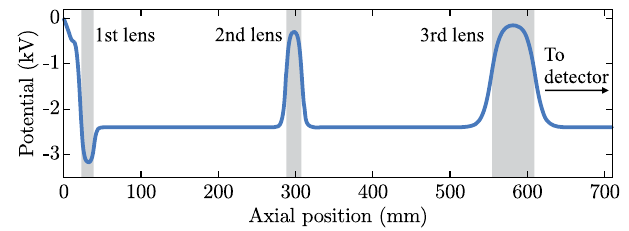
FIG. 8. Example of the axial electrostatic potential. The curve shown corresponds to an electrode voltage configuration ; V ; V ; V ; V ; V (cid:3) ¼ ½ 500 ; − 500 ; − 3200 ; − 250 ; − 110 ; of ½ V 1 2 3 R E D − 2400 (cid:3) V. The shaded regions mark the position of the main electrodes of the three lenses. The potential stays flat for the remaining distance to the detector, which is located at 1350